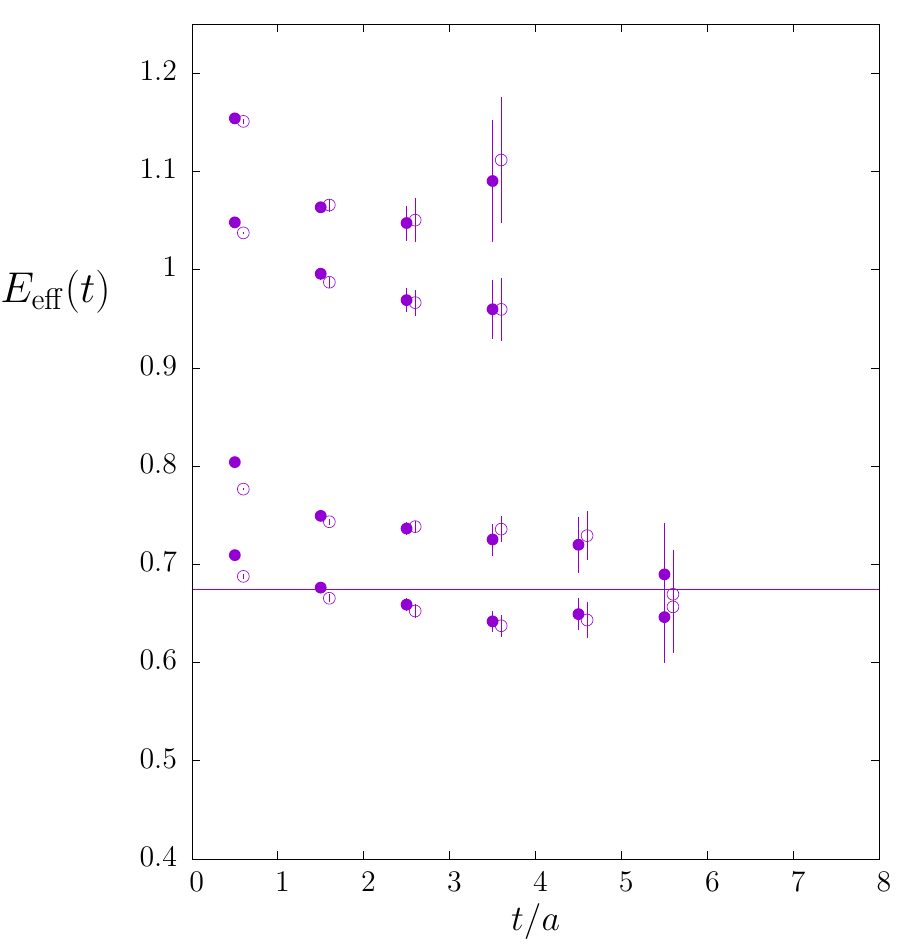
Figure 4 . Effective energies of the lightest E ++ states from the basis of the usual single loop operators, • , and from the same basis but extended with our ditorelon operators, ◦ . Horizontal line is the energy of the lightest ditorelon state neglecting interactions between the torelons. On a 18 3 26 lattice at β = 6 . 235